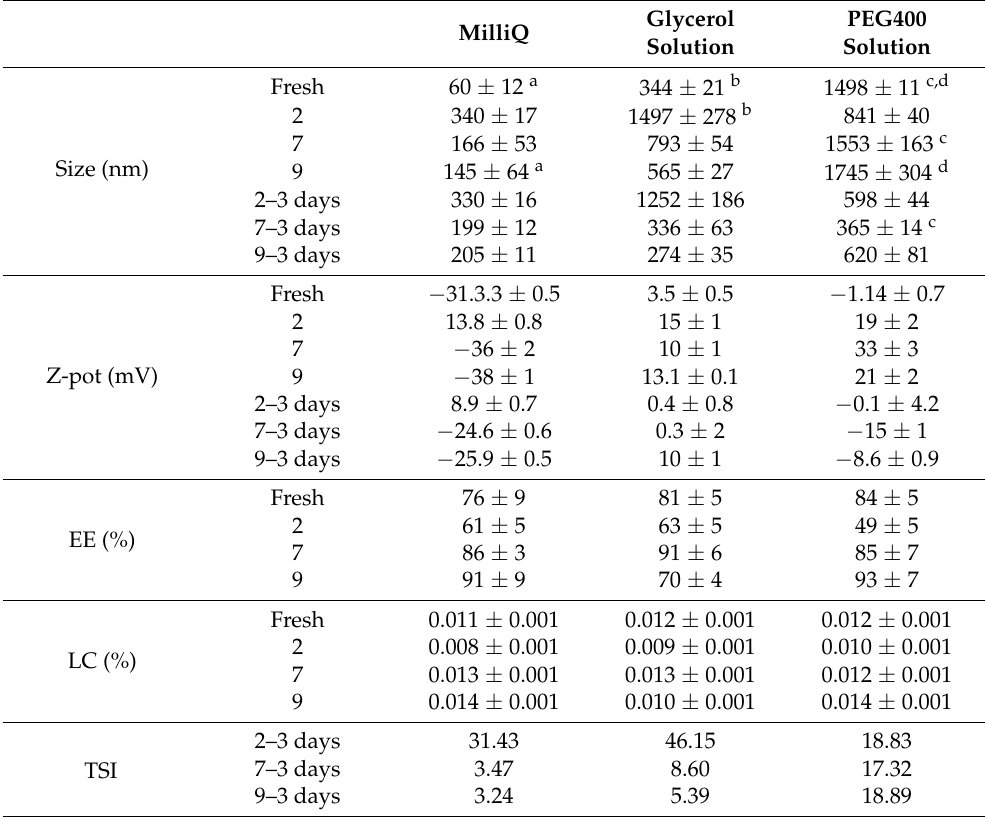
Table 4. Physical properties of vesicles hydrated in three aqueous phases at natural pH and at other pHs (2, 7, 9), fresh and after 3 days under